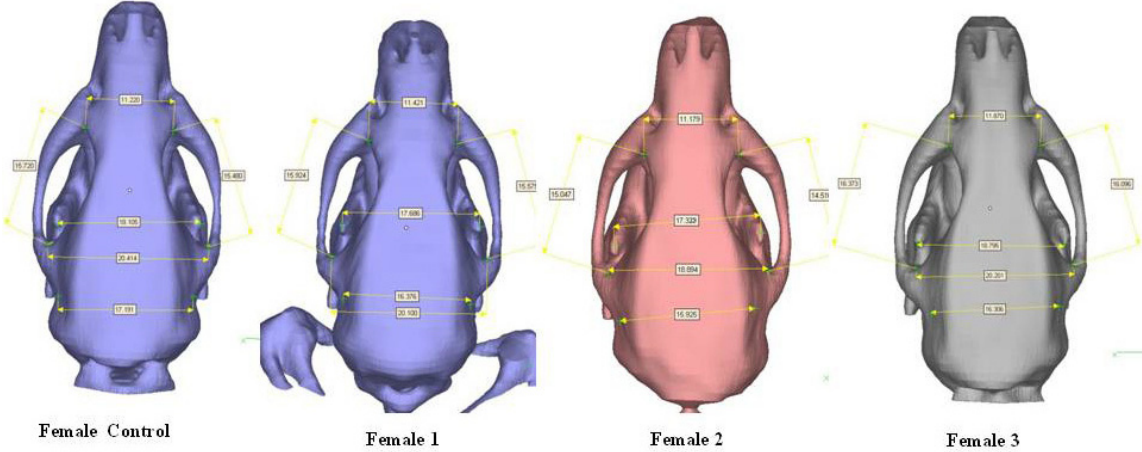
FIGURE 5 - Computed tomography images showing superior view of the craniofacial skeleton of female rat borne of restrained mother and that of its age-matched from the control group at 1 year and 2 months of age. Note landmarks of radiologic